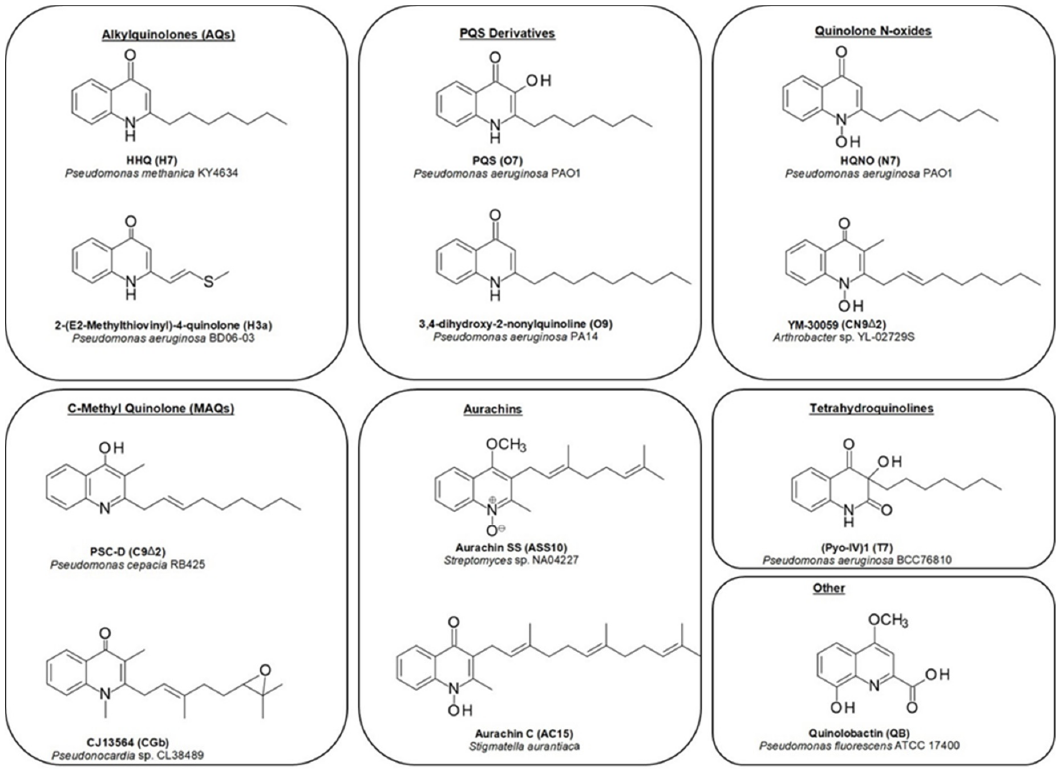
Figure 2. Chemical structures of selected quinolones and producing organisms.